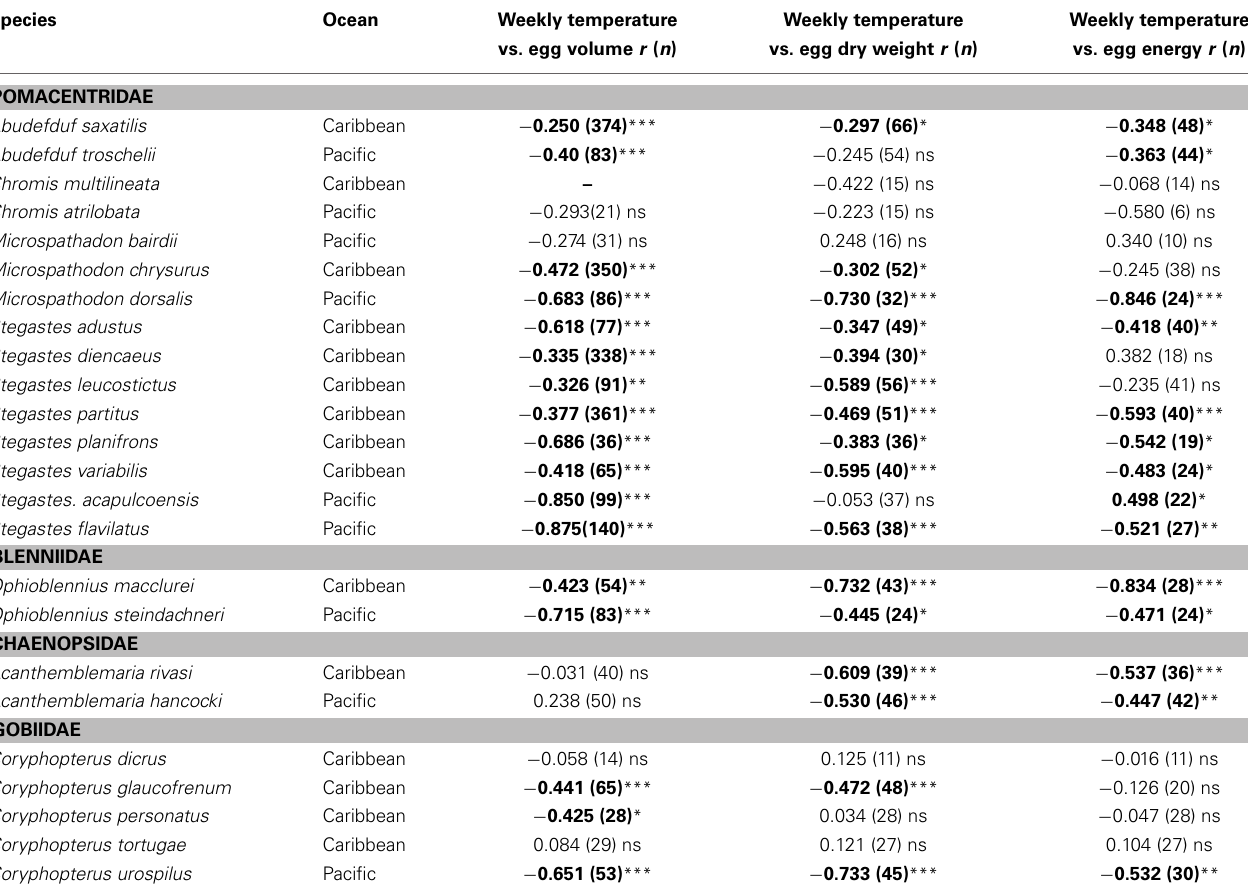
Table 4 | Pearson Correlations between average weekly temperature across years and egg volume, egg dry weight, and egg energy content within species of the 24 neotropical reef fishes